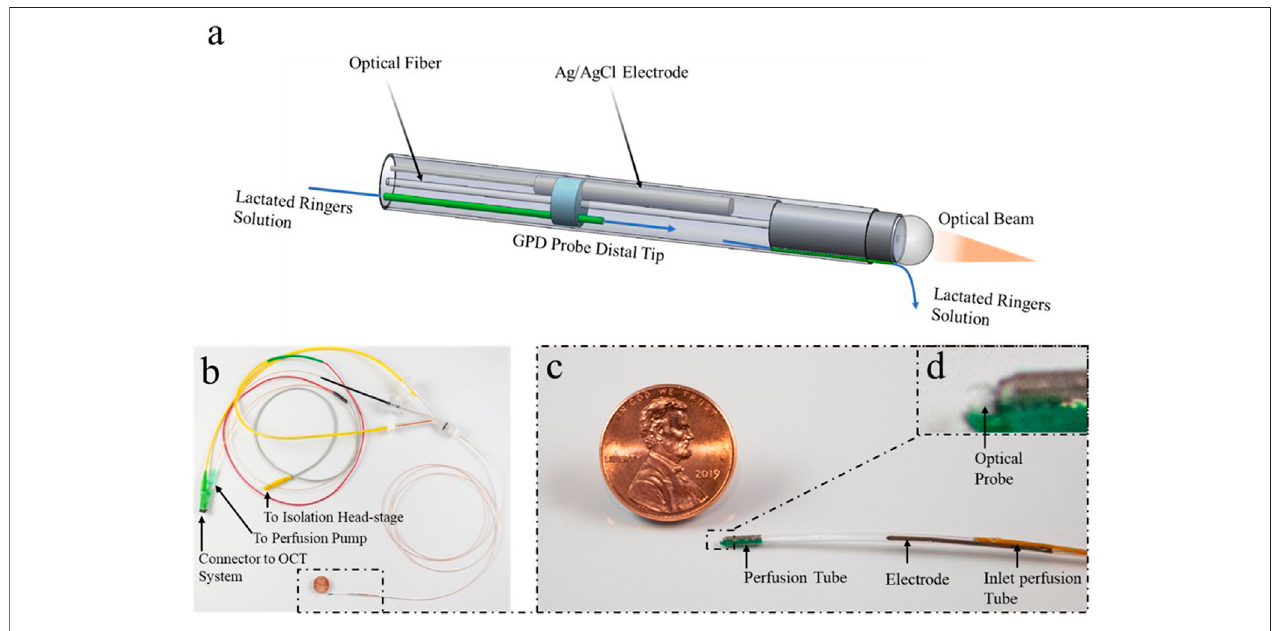
FIGURE 1 | The GPD probe consists of a mini cell at the tip and the proximal connectors. (A) The tip is enclosed in a 1.2 mm outer diameter (OD) polytetra fl uoroethylene (PTFE) tube with a0.5 mm diameter Ag/AgCl electrode, an optical probe consisting ofaball lens and a single mode fi ber (SMF), aperfusion tube that delivers lactated Ringer ’ s solution to the mini cell and perfusion channel that conducts a drip of lactated Ringer ’ s solution to the exteriorly located tissue. (B) The proximal end consists ofaLuer lock connector to theperfusiontube from aperfusion pump, an optical connectorfrom anOCT system tothe optical probeand an electrical connector that links a wire from the Ag/AgCl to the isolation head-stage. (C, D) A Magni fi ed view of the GPD probe.